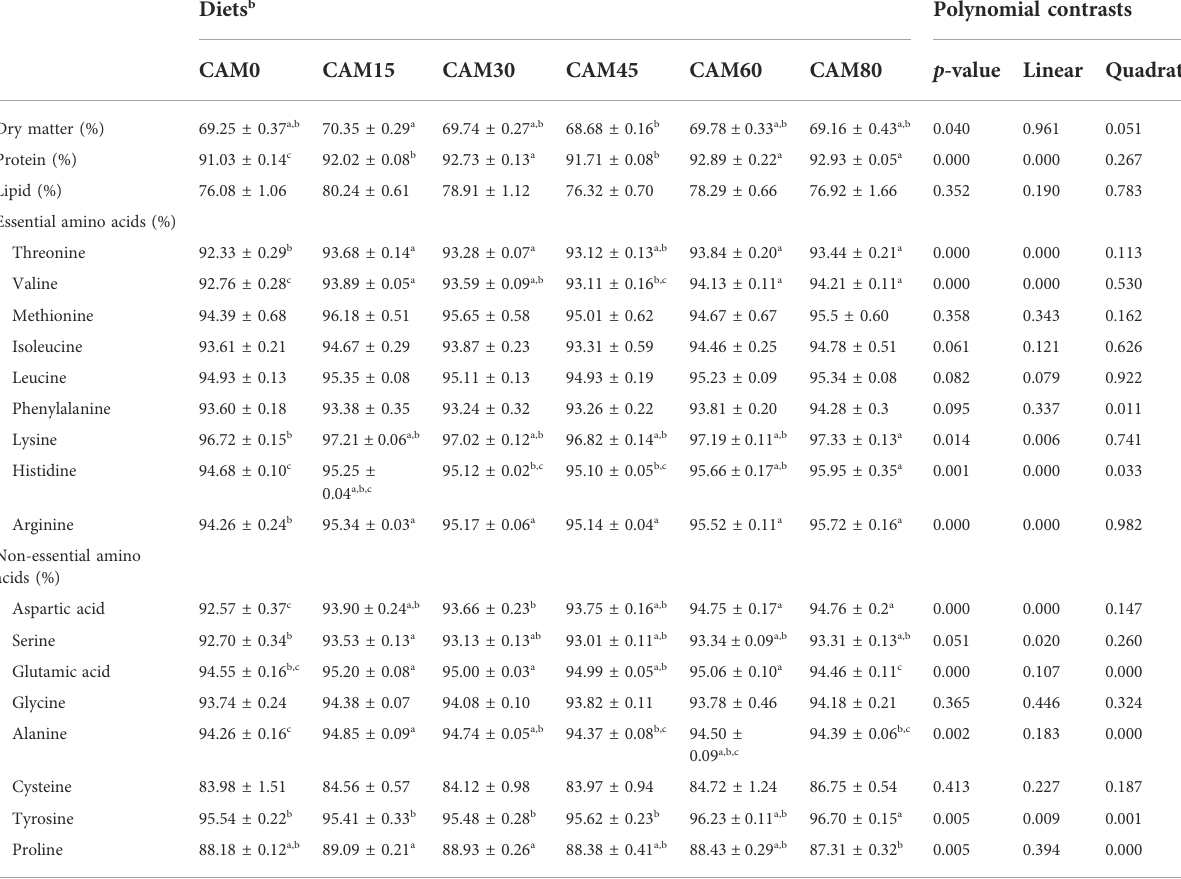
TABLE 9 Apparent digestibility coef fi cient of dry matter, protein, lipid and amino acids of the experimental diets (Means ± S.E.M) a . Diets b Polynomial